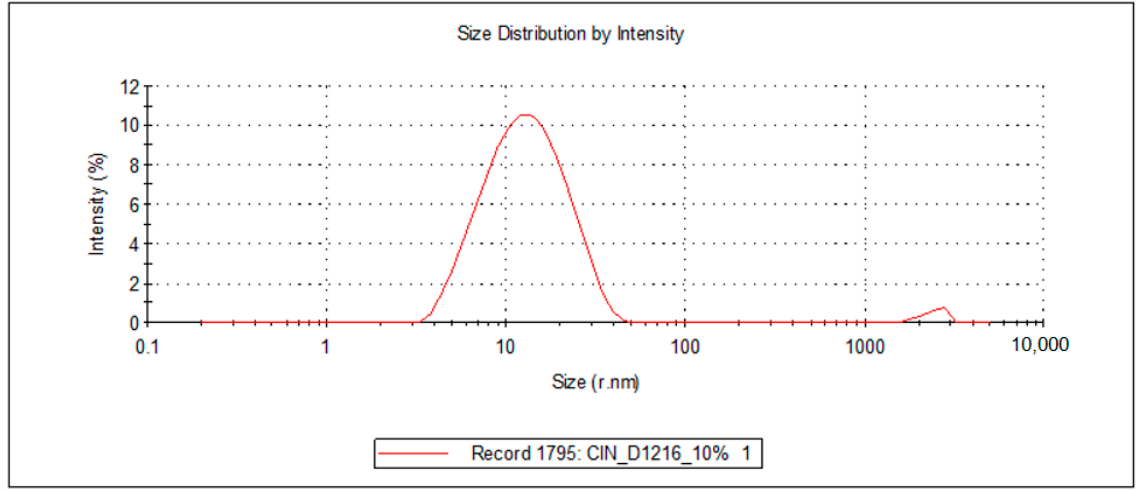
Figure 4. Droplet size distribution of the FZ-loaded microemulsions based on cinnamon essential oil and sucrose ester (sucrose palmitate or laurate).